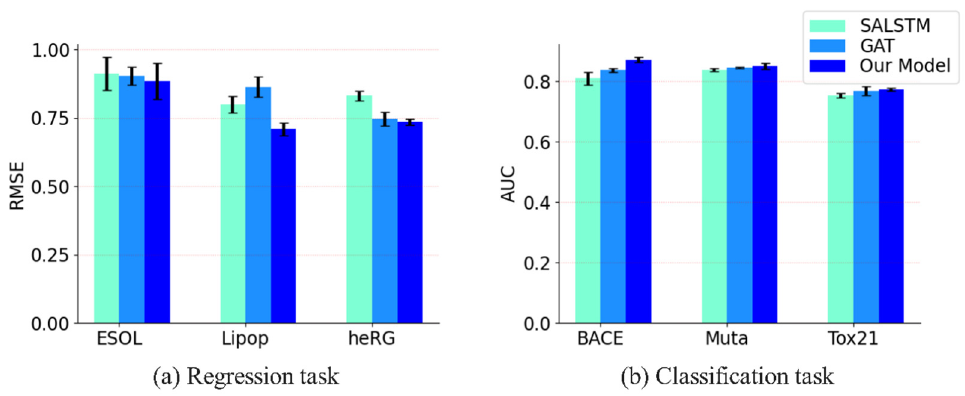
Figure 5. The performance of SALSTM, GAT and our model; the number of augmented samples is 5. ( a ) The performance in the regression task. ( b ) The performance in the classification task. Error bars indicate standard deviation under 5 ‐ fold cross ‐ validation.